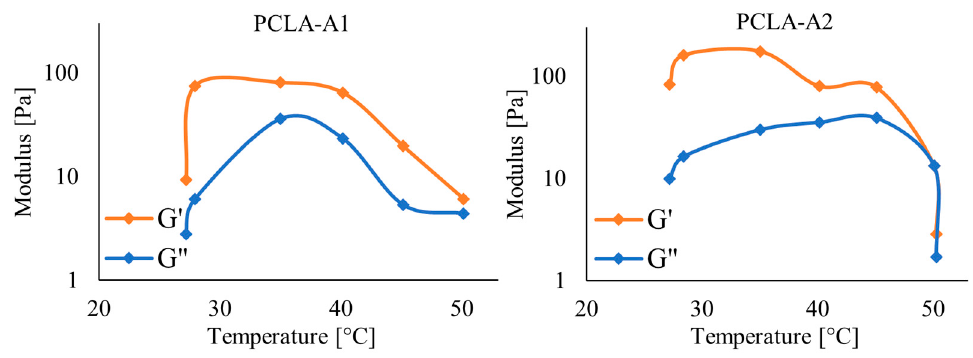
Figure 6. G’ and G” data of the PCLA-A1 and PCLA-A2 hydrogels as a function of temperature.